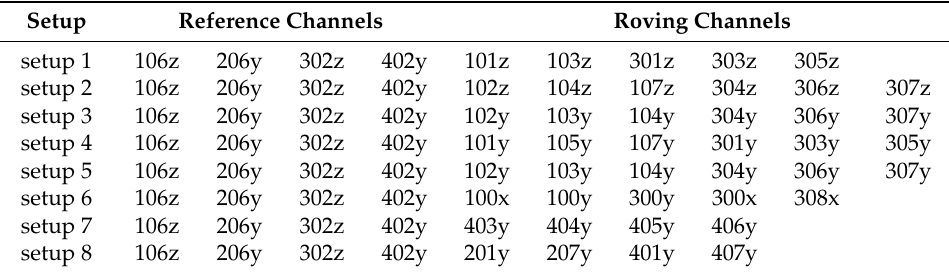
Table 1. Overview of setups used for data acquisition and corresponding